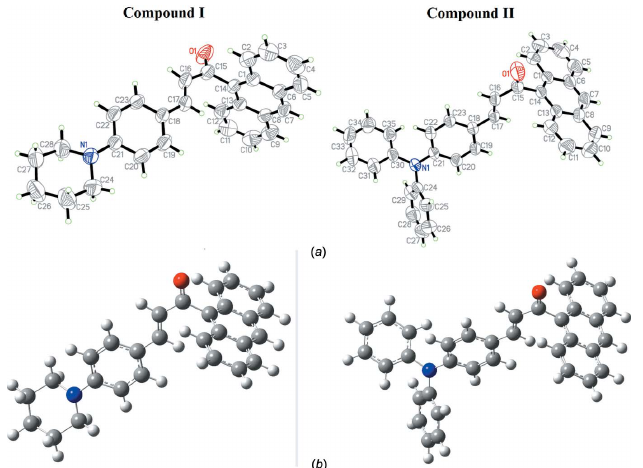
Figure 1 (a) The molecular structure of compounds (I) and (II) with 50% probability displacement ellipsoids. (b) The optimized structures of compounds (I) and (II) at the DFT/B3LYP 6–311++G(d,p) level.